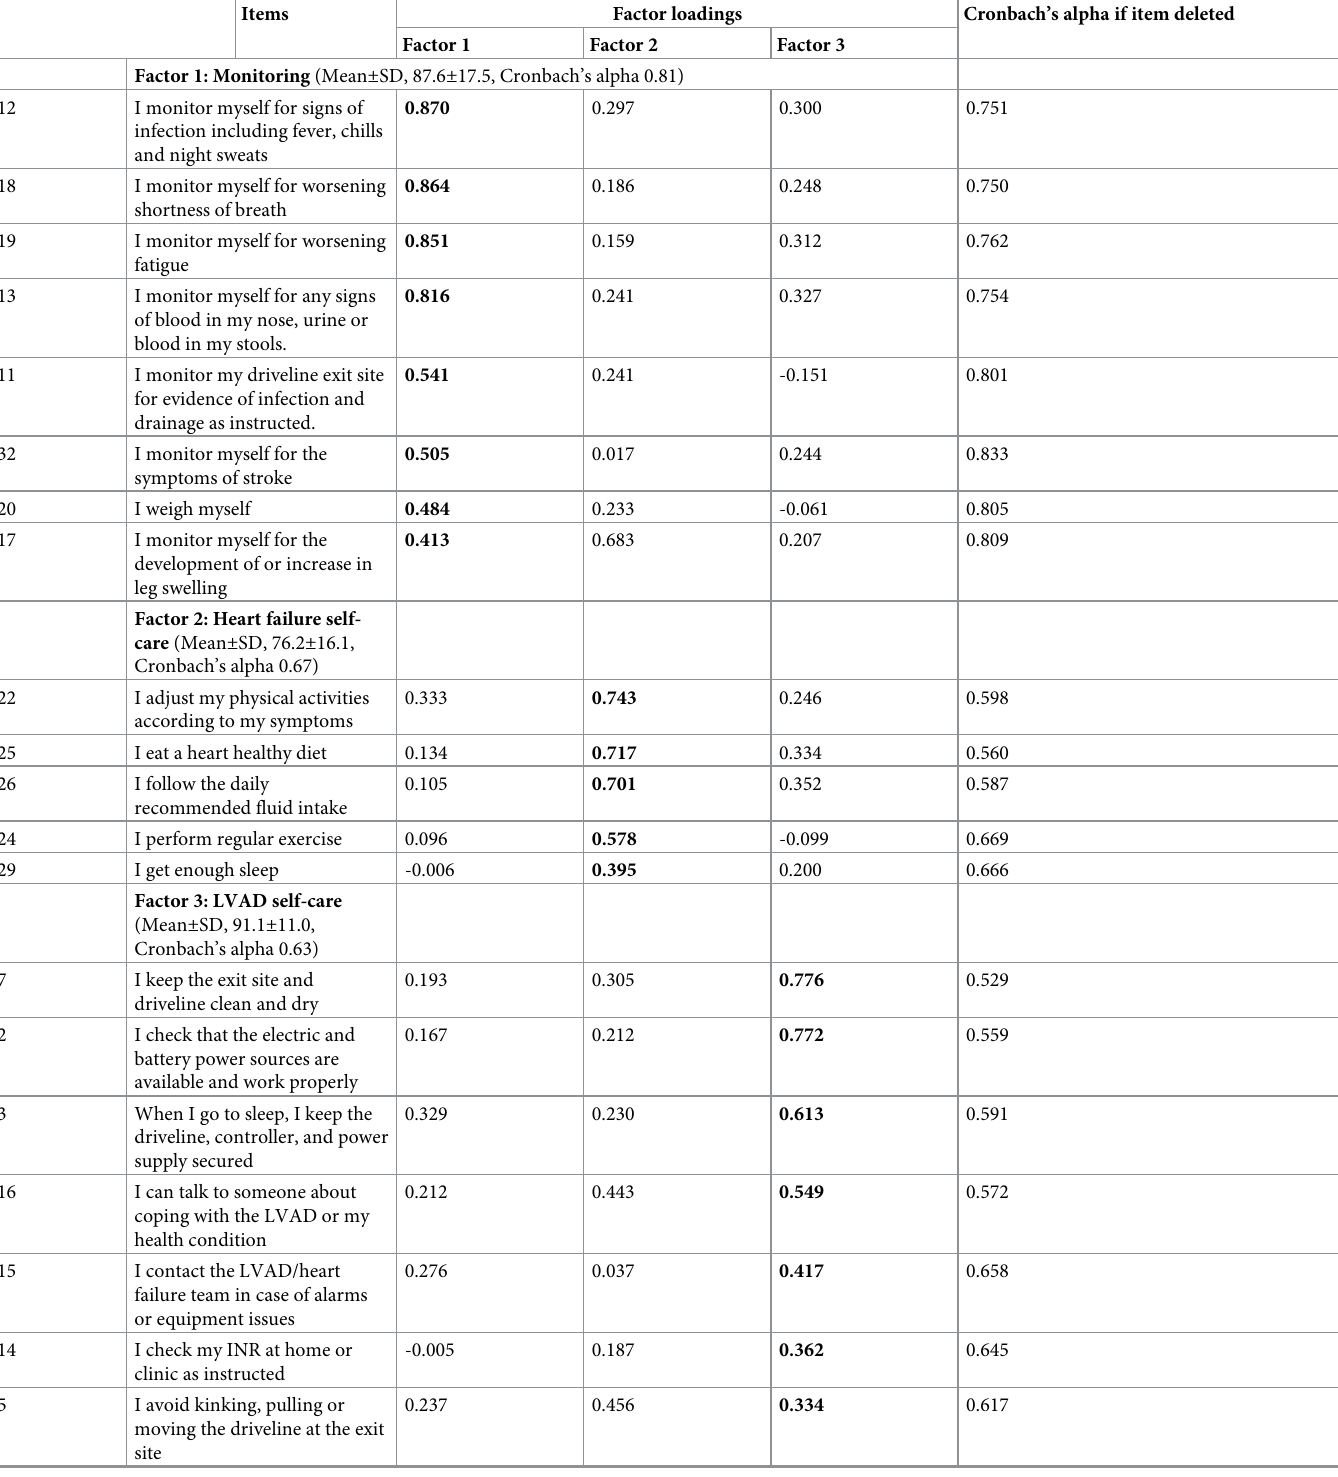
Table 4. Results of exploratory factor analysis using Promax rotation: 20-item LVAD self-care behaviour scale (N = 127).